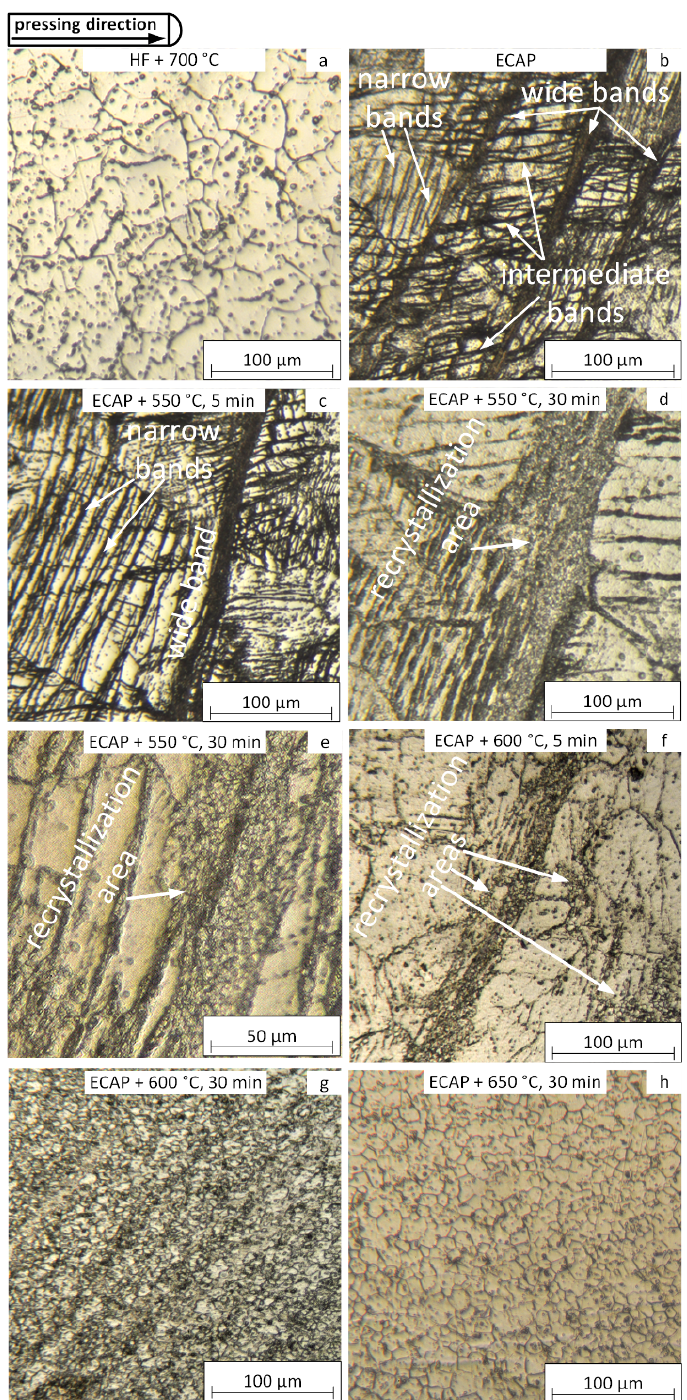
Figure 3. Microstructure of the Ti ‐ 18Zr ‐ 15Nb alloy after: ( a ) HF + 700 °C, 30 min; ( b ) ECAP; ( c ) ECAP + PDA 550 °C, 5 min; ( d ) ECAP + PDA 550 °C, 30 min; ( e ) ECAP + PDA 550 °C, 30 min (image with greater magnification); ( f ) ECAP + PDA 600 °C, 5 min; ( g ) ECAP + PDA 600 °C, 30 min; ( h ) ECAP + PDA 650 °C, 30 min.